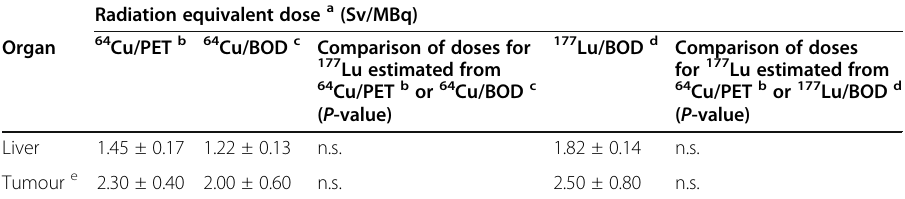
Table 4 Radiation equivalent doses in the tumour and liver in NRG mice with s.c. HNSCC primary xenografts for [ 177 Lu]Lu-DOTA-panitumumab F(ab´) 2 based on ROI analysis of biodistribution (BOD) Radiation equivalent dose a (Sv/MBq)